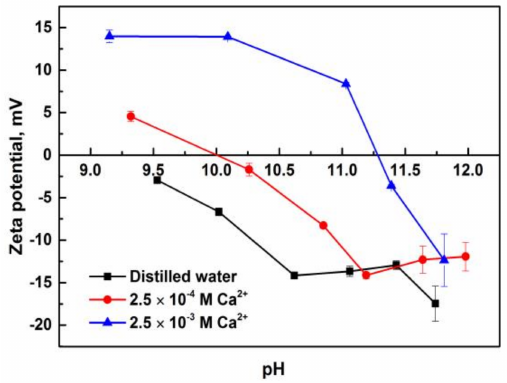
Figure 7. Zeta potential of dolomite as a function of pH in the absence and presence of calcium ions.